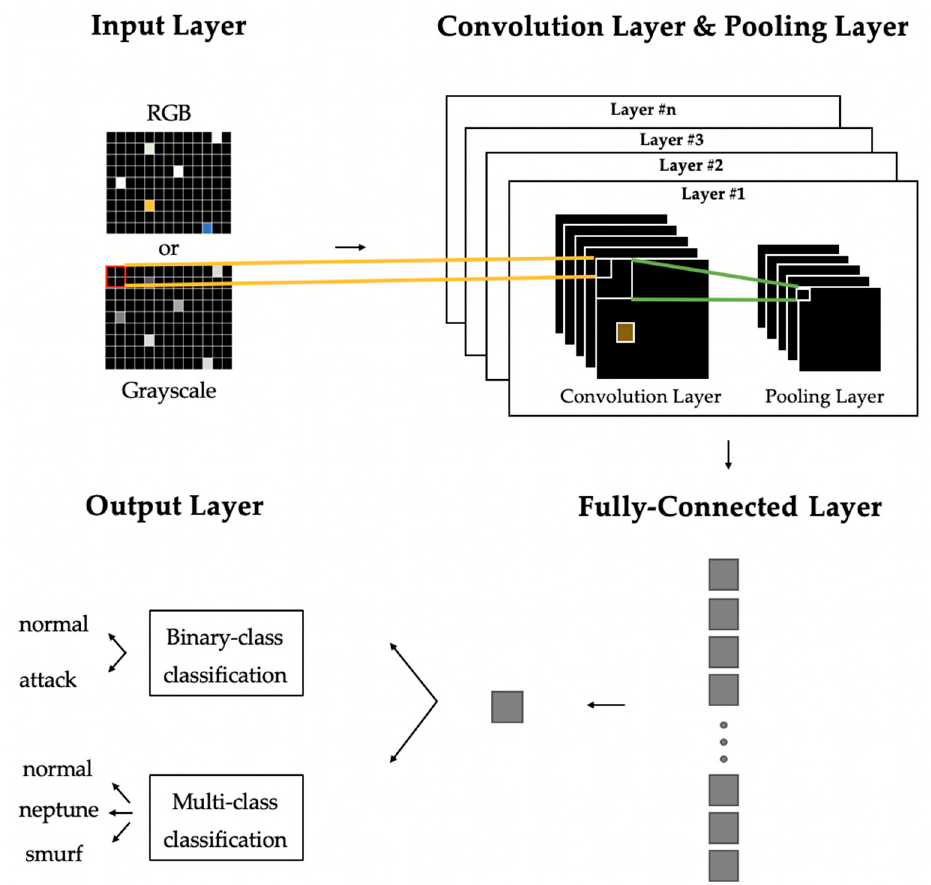
Figure 2. Design of our CNN model.